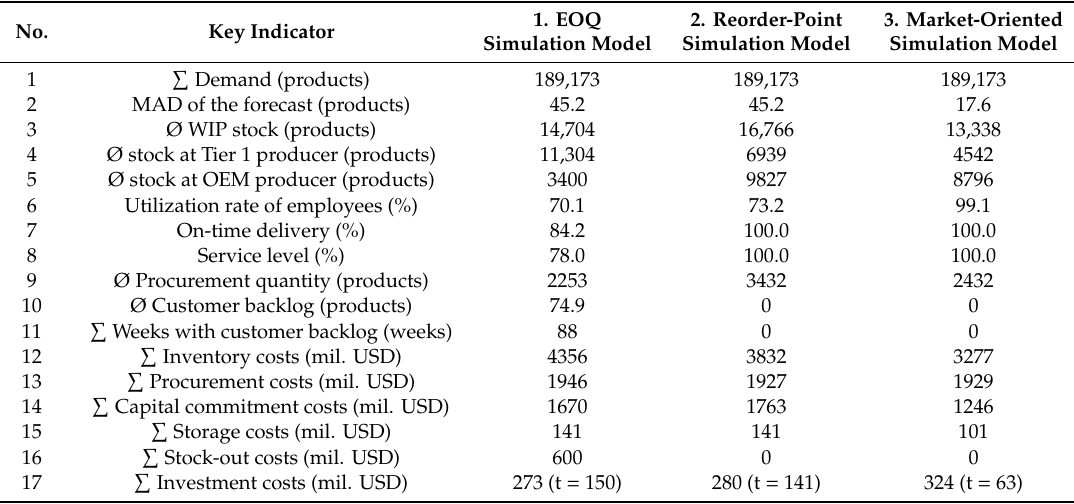
Table 13. Simulation results for the fifth demand